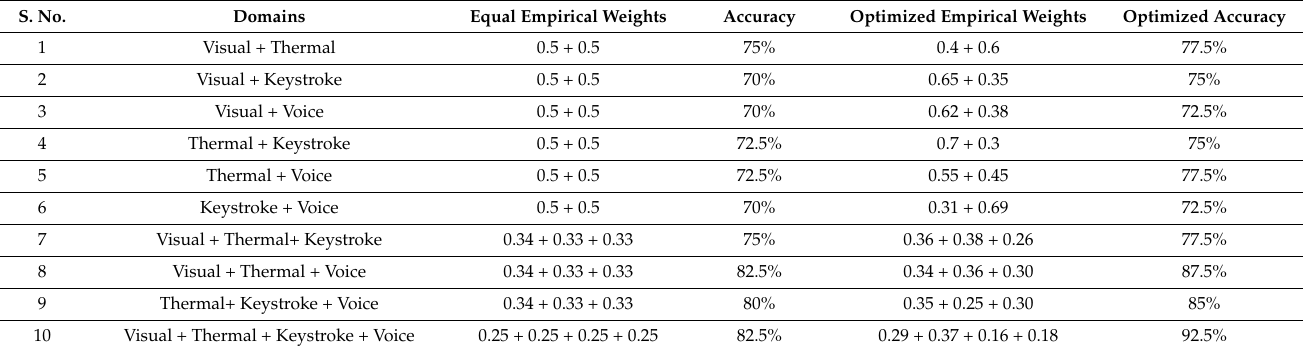
Table 5. Detection accuracy matrix from the individual